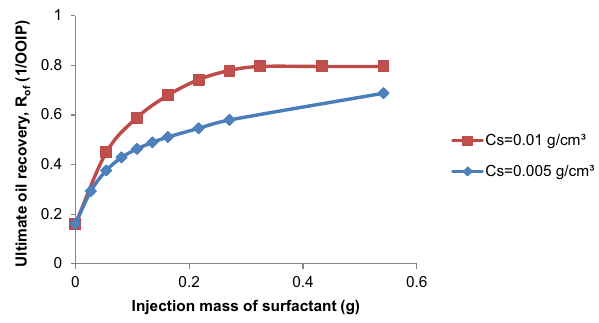
Fig. 22 The relationship between injection mass of surfactant and the ultimate oil recovery obtained with different injection surfactant con- centration